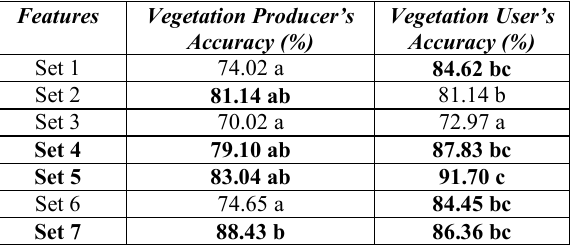
Table 8. Comparison of mean values of producer and user accuracy for “vegetation” class and the seven set of features.